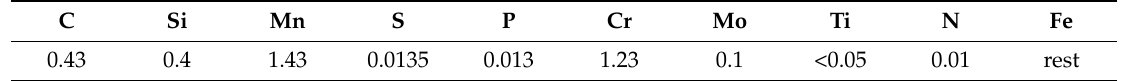
Table 1. The chemical composition in wt. % for the steel that was used for both samples. C Si